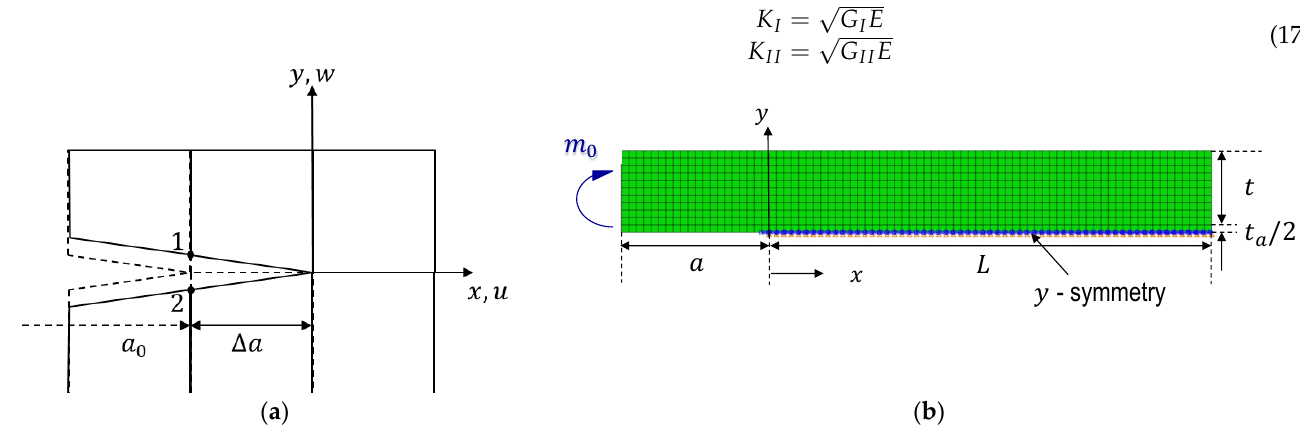
Figure 8. The crack closure integral method and implementation in the SIF calculation in this study. ( a ) Crack closure integral illustration. ( b ) A representative 2D FE model used for Case 1 in Figure 7a.